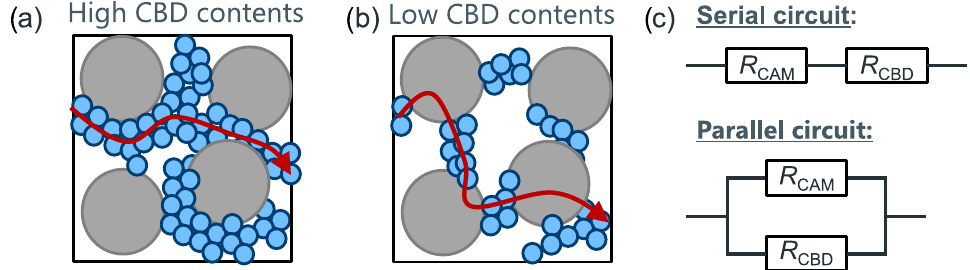
Figure 2. Schematic depiction of current pathways at low ( a ) and high ( b ) CBD content; ( c ) equivalent circuits of the serial and parallel connections modeling the effective solid phase